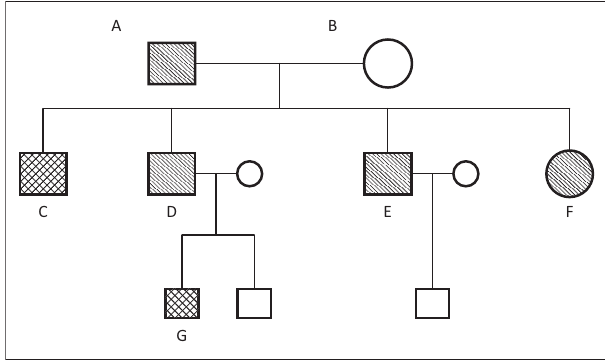
FIGURE 1: Psychiatric diagnosis of family members: A. Bipolar mood disorder C. Schizophrenia (22q11DS) D. Major depressive disorder and craniostenosis E. Major depressive disorder F. Clubfeet G. Intellectual disability, white matter